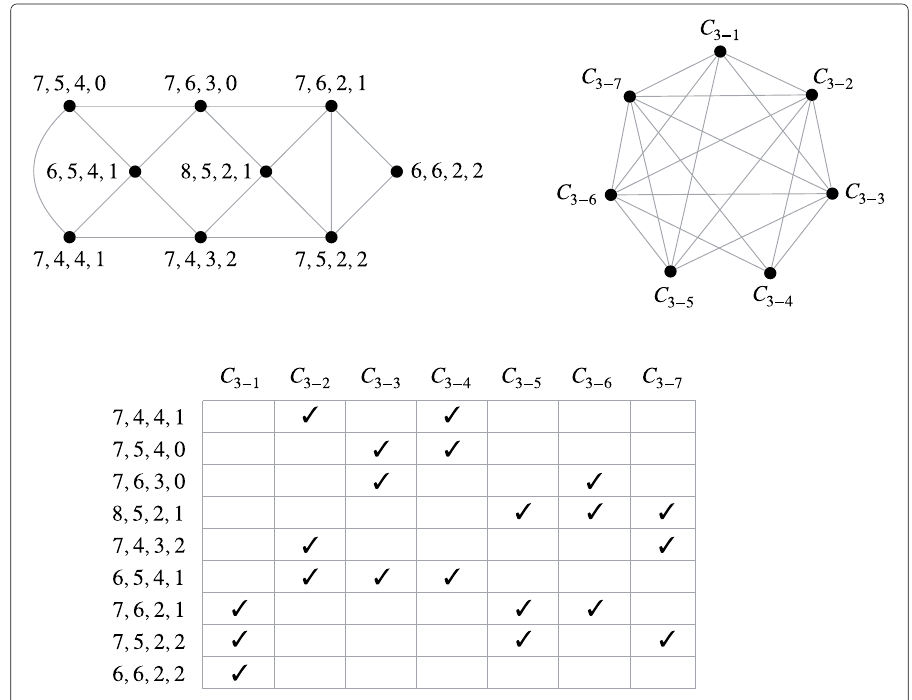
Fig. 6 The example of overlapping cliques. Graph G ( | V | = 9, | E | = 15 ) ∈ G ( V P ( 16,4 ) , E 4 ) (top left) and its 3-clique graph G Cl ( | Q | = 7, | E | = 19 ) (top right). The matrix below shows nodes for each